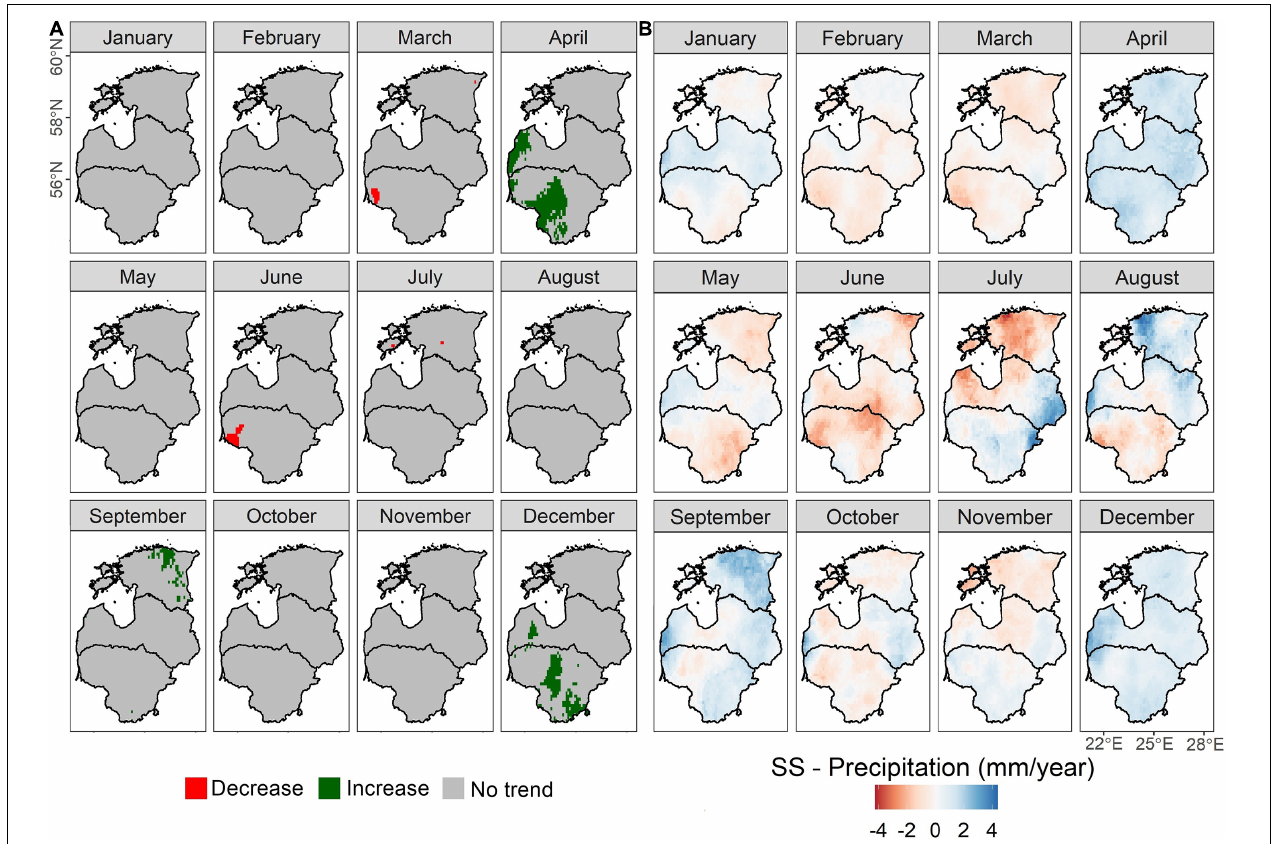
FIGURE 2 | (A) The results of the Mann-Kendall test for statistically significant ( p < 0.05) trends in monthly precipitation at the pixel level. (B) Sen’s slope (SS) values for changes in precipitation. Positive values represent increasing and negative values represent decreasing